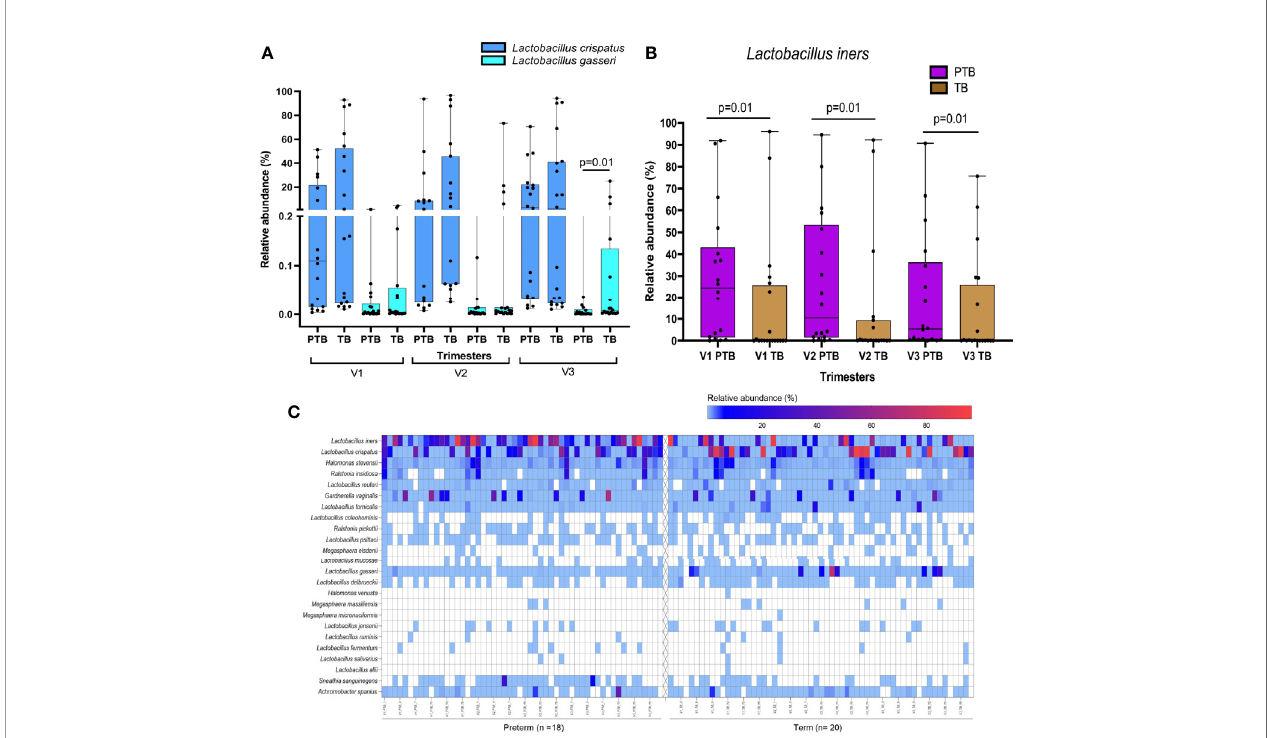
FIGURE 2 | Box plots showing differential abundance of L. crispatus, L. gasseri (A) , and L. iners (B) between TB and PTB samples. L. gasseri was found to be signi fi cantly higher in the TB compared to PTB samples (3rd trimester only). L. iners was found to be signi fi cantly higher in PTB compared to TB samples in all the trimesters. (C) Heatmap representing species level composition of those genera with mean relative abundance >1% in either term or preterm group in any of the three trimesters. Left panel of the heatmap is for the PTB samples while the right side is for the TB